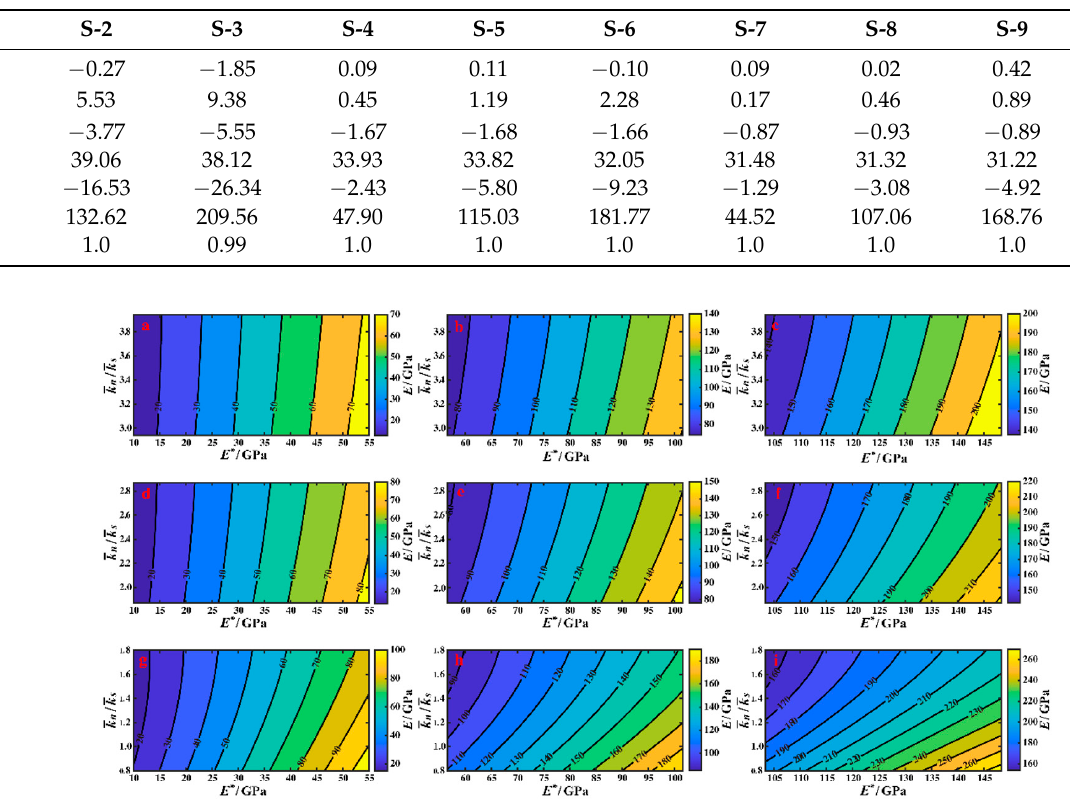
Table 8. Response surface equation of elastic modulus.